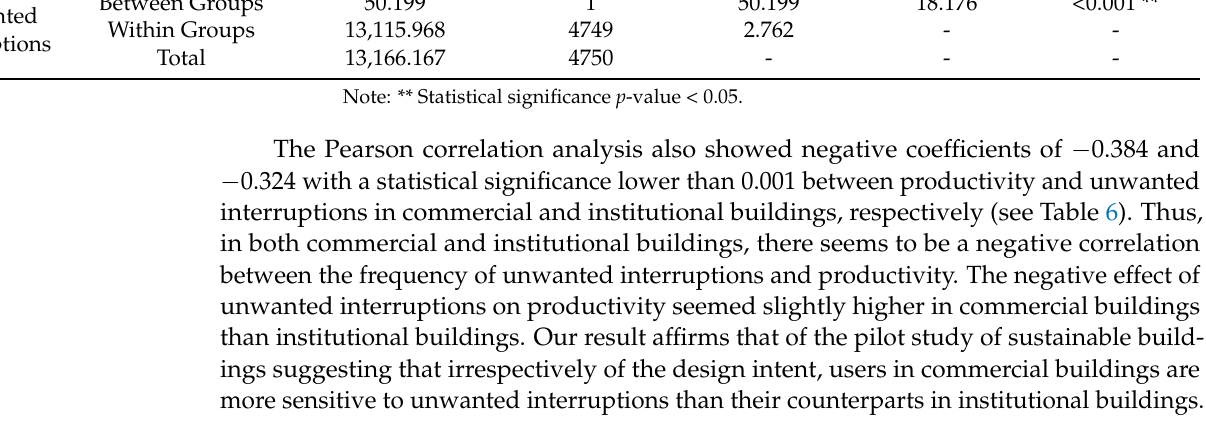
Table 6. Pearson correlation comparing productivity and unwanted interruptions in commercial and institutional building groups.